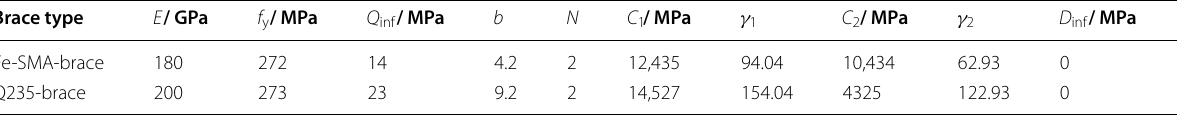
Table 6 Calibrated UVCuniaxial parameters for the brace